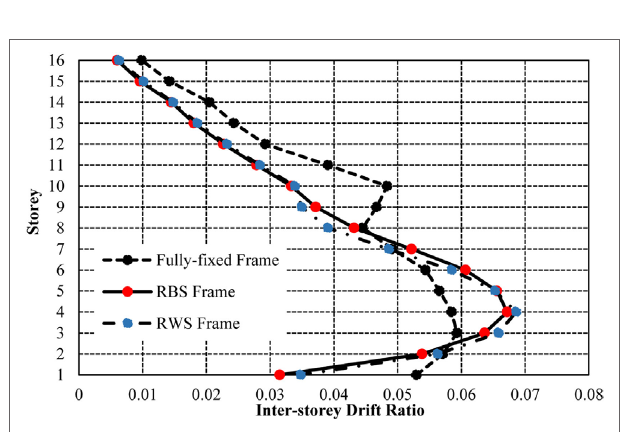
Figure 25 | 16-storey frame inter-storey